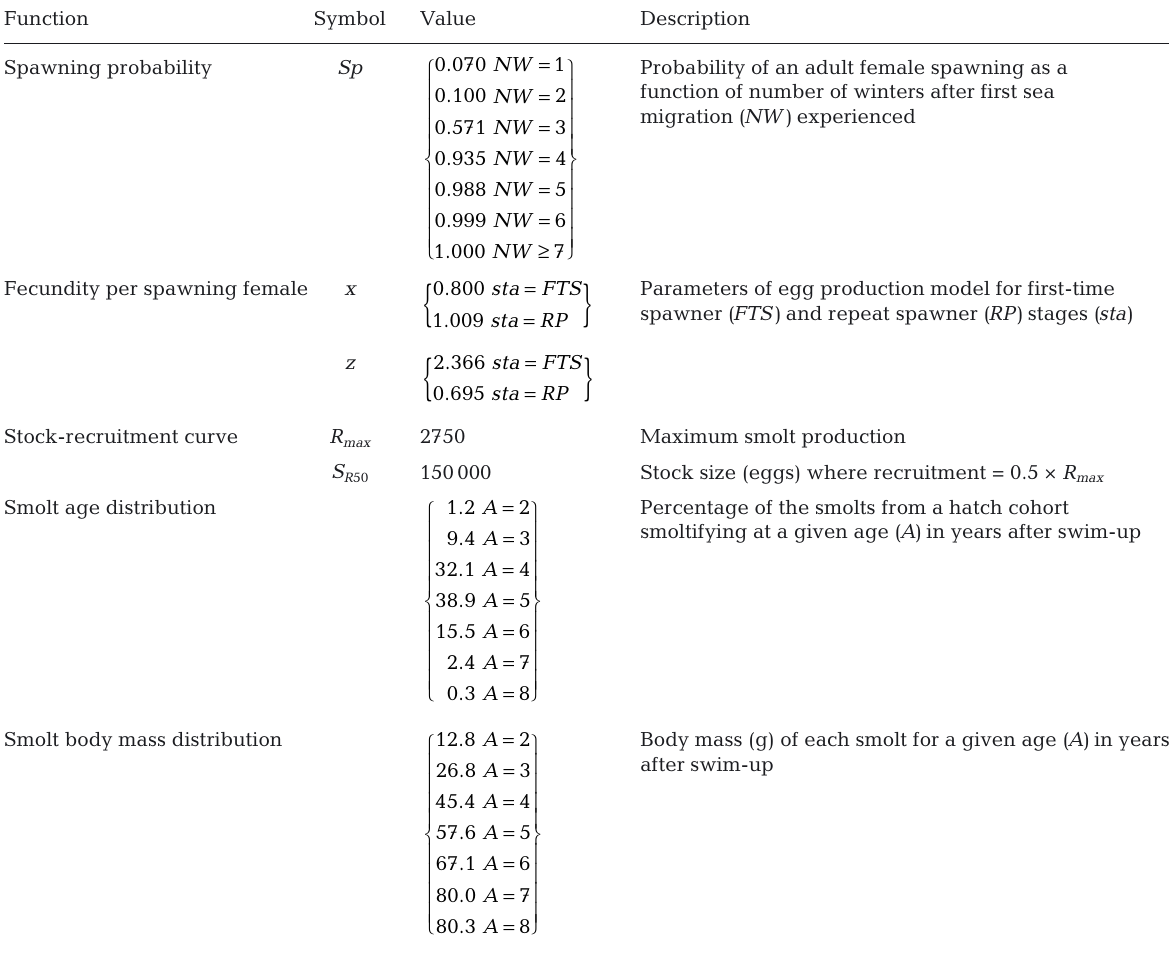
Table 2. Parameters of egg deposition, stock-recruitment, and smolt